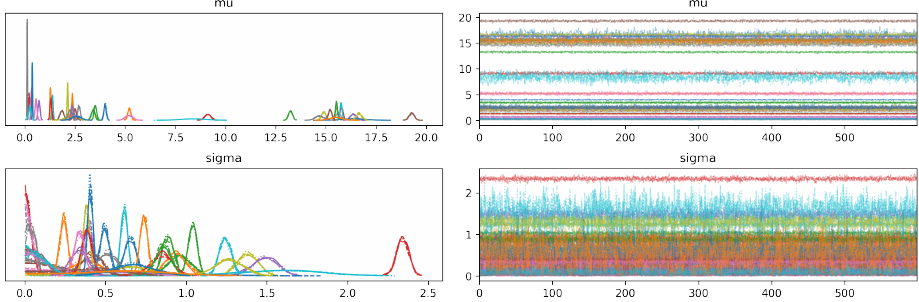
Figure 13. Posterior trace for types and dates model.